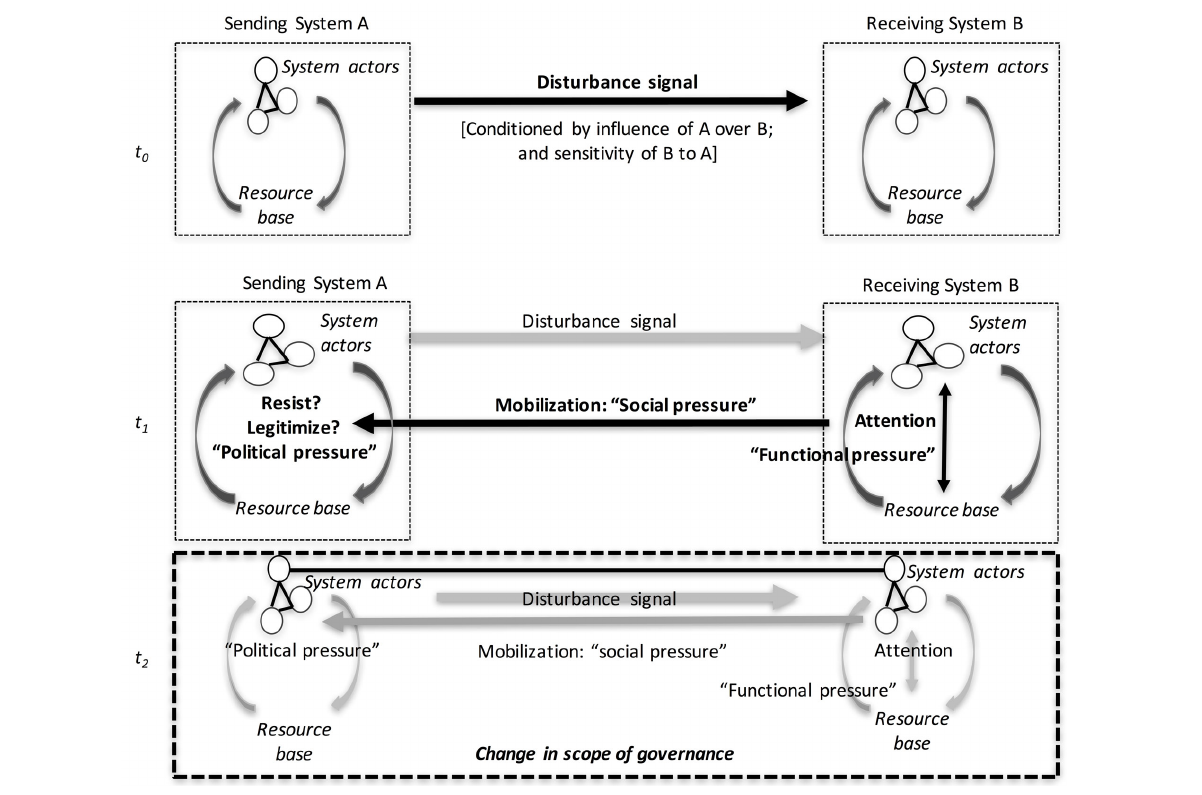
Fig. 2 . Conceptual model of how the recognition of telecoupling may trigger change in